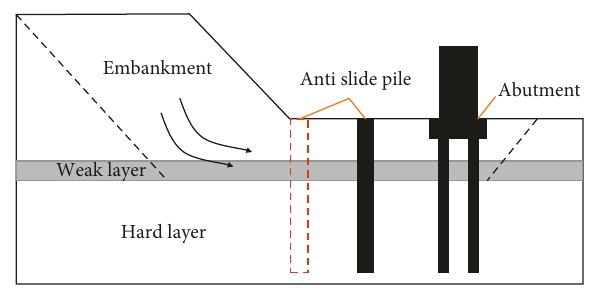
Figure 12: Schematic diagram of bridge foundation stress near embankment slope.